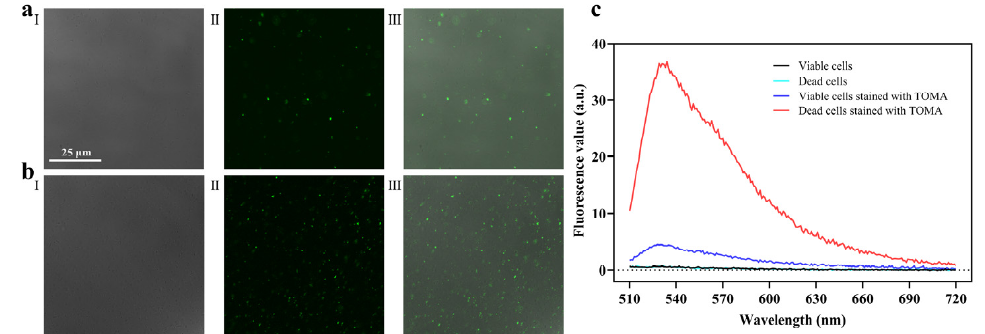
Figure 2. Characterization analysis of the permeability of TOMA to the cell membrane. CLSM images of ( a ) viable Salmonella and ( b ) dead Salmonella : ( I ) light image with no stain; ( II ) with TOMA treatment; ( III ) merged image; ( c ) Fluorescence emission spectrum (the excitation wavelength was 488 nm) of Salmonella after the TOMA